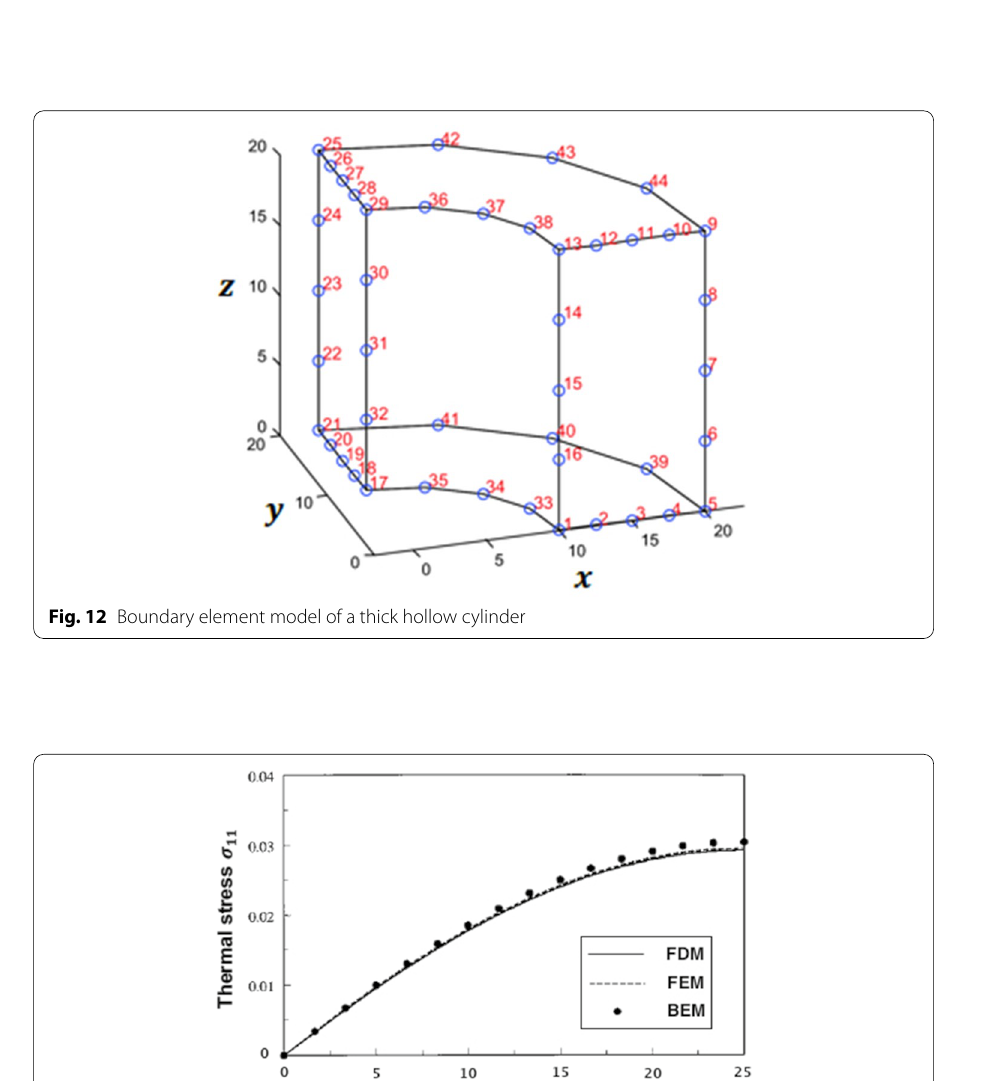
Fig. 11 Variation of the nonlinear displacement u 2 with time τ for FDM, FEM and BEM